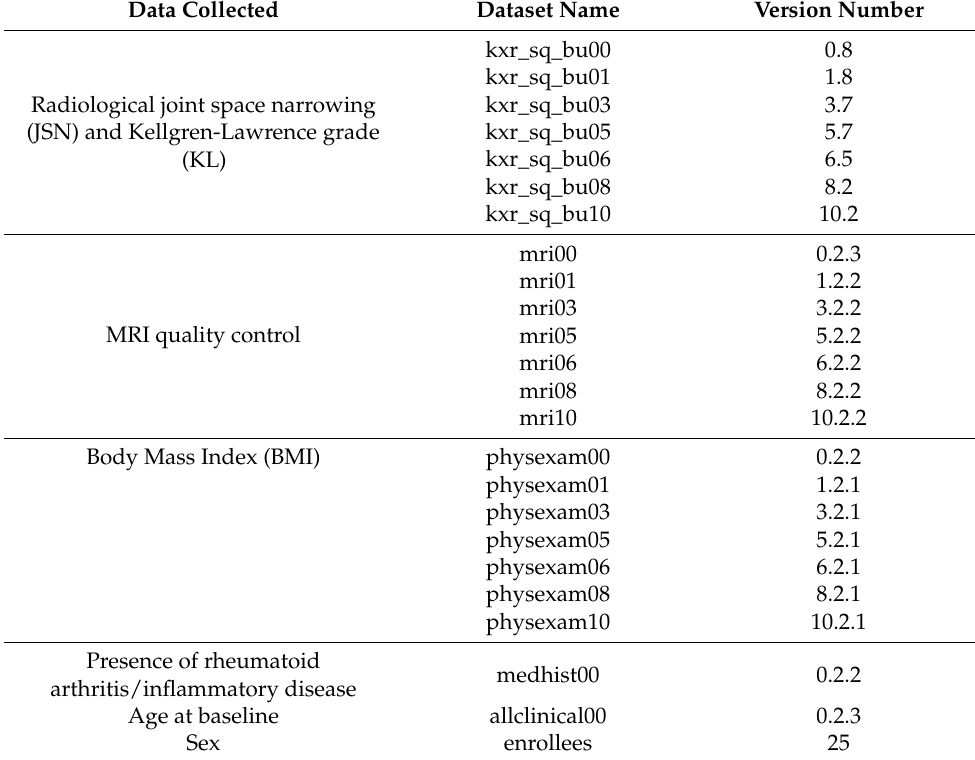
Table A1. Osteoarthritis Initiative dataset versions used for study cohort identification and